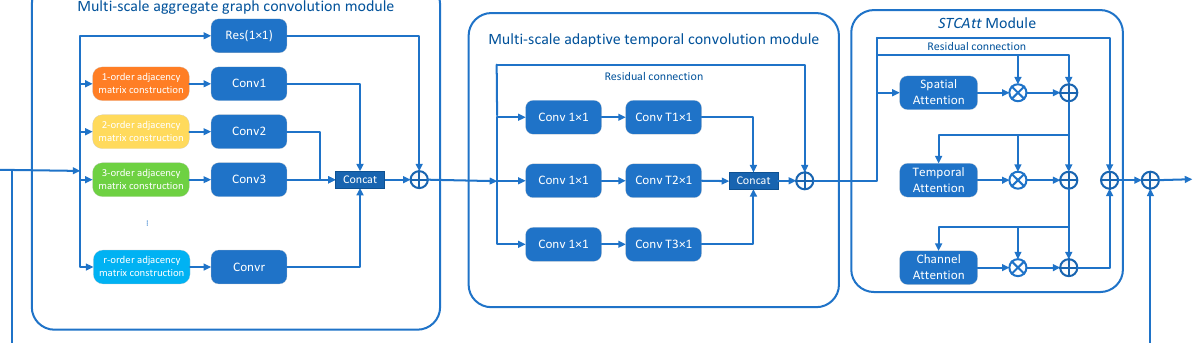
Figure 1. The architecture of the proposed spatial-temporal-attention module (STAM). It contains a multi-scale aggregate graph convolution module for modeling spatial information of the skeleton sequence. Multi-scale adaptive temporal convolution module is used to capture temporal features of different time ranges (T1, T2 and T3), and the attention module is applied to focus on meaningful information. The residual connection is applied on each STAM. ⊕ denotes element-wise sum, and ⊗ denotes element-wise multiplication.